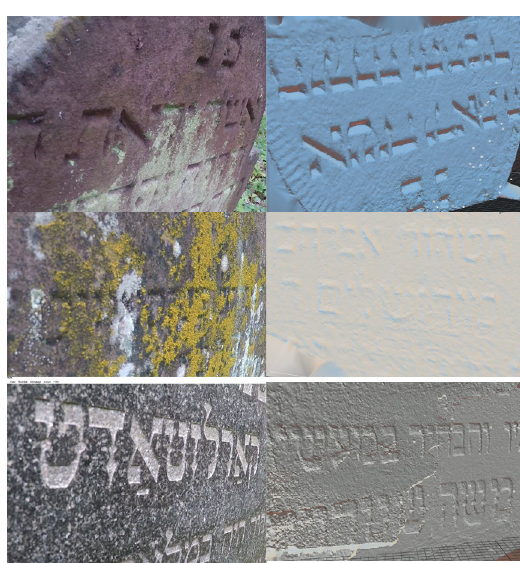
Figure 4. Examples of gravestones captured with GoPro camera (left, stills extracted from video) and processed in Reality Capture (right).